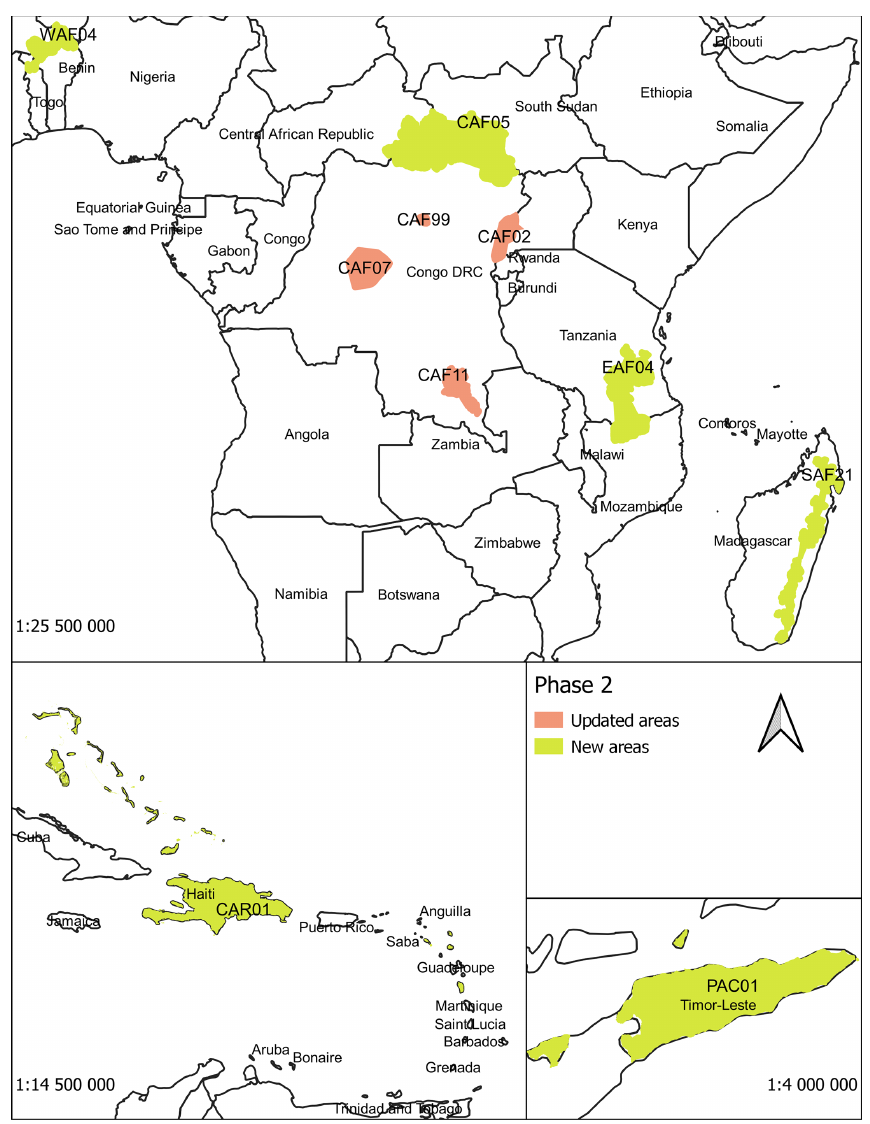
Figure 1. Spatial distribution of the key landscapes for conservation Phase 2 areas.